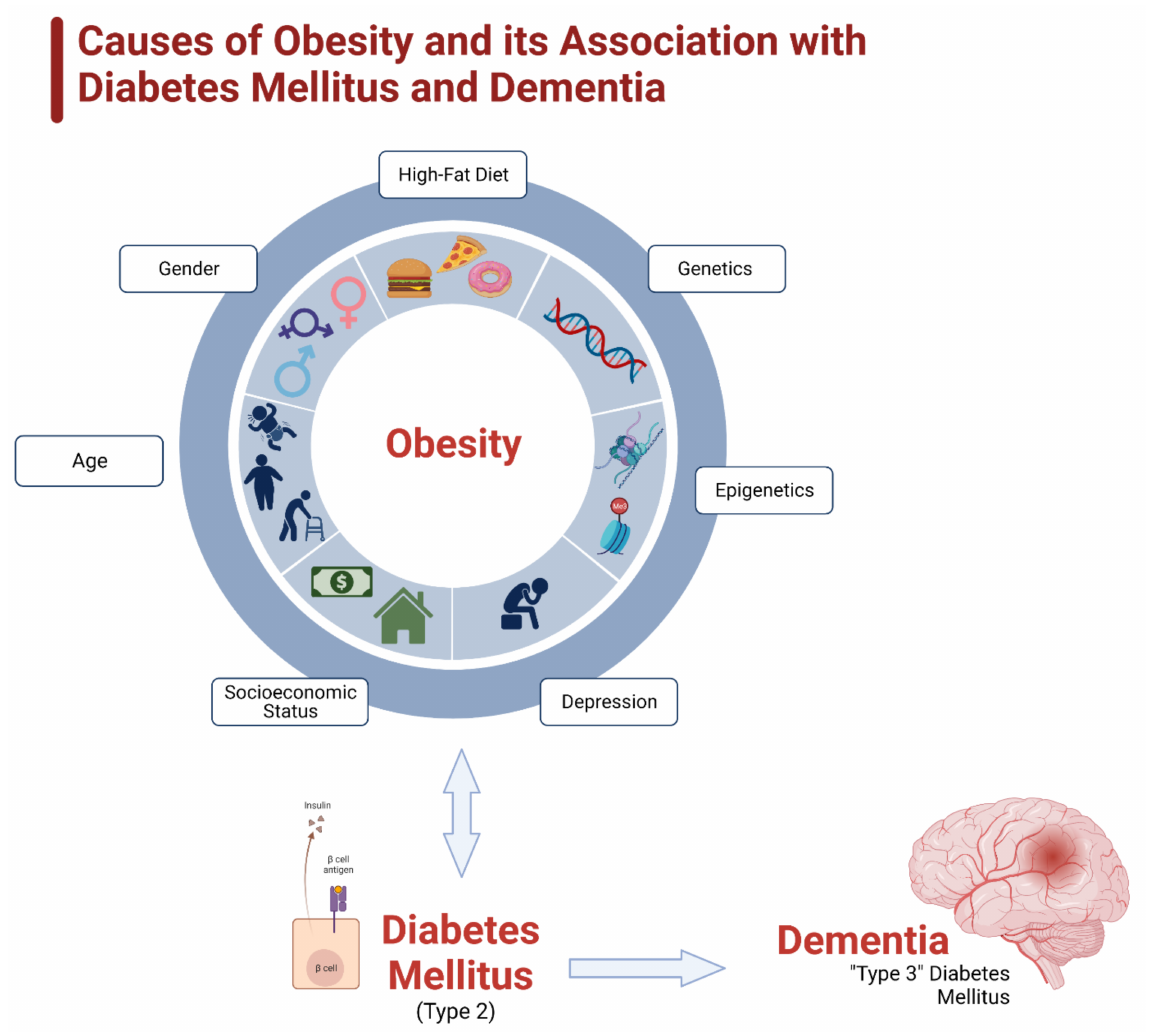
Figure 2. Causes of obesity and its association with diabetes mellitus and dementia. Obesity is a multifactorial condition, determined by not just an imbalance of caloric intake and usage, but also by several other factors. The main determining factors are age, gender, diet, genetic predisposition, epigenetic impact, depression, and socioeconomic